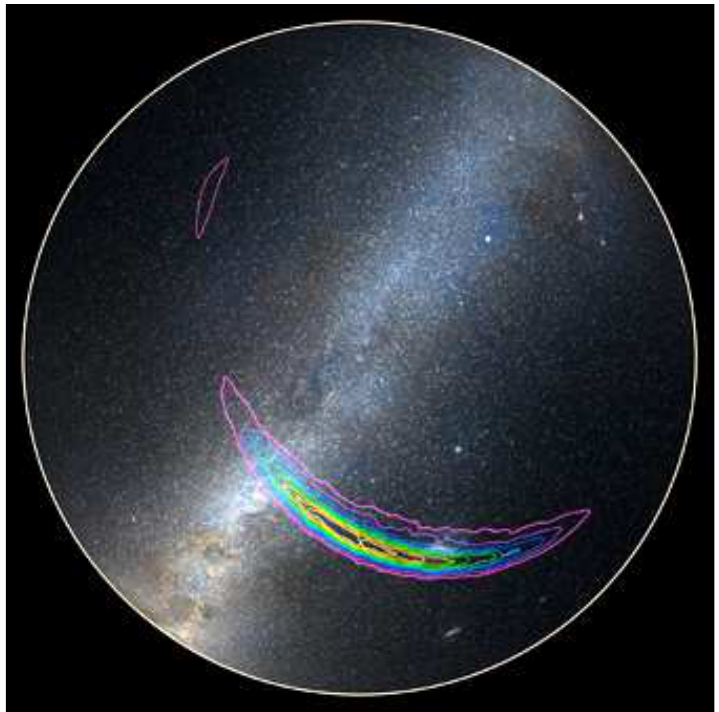
Figure 6. The sky localisation of GW150914 is depicted in this figure. The source of gravitational radiation could be spread over several 100 sq.deg. This is a large region in the sky compared to the area spanned by sun which is merely 0.5 sq.deg. (Image credit: